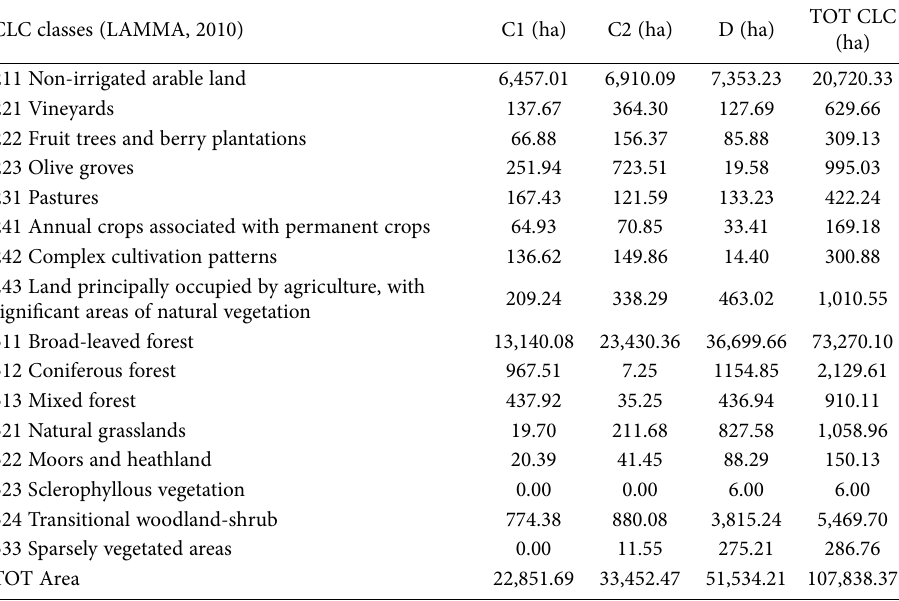
Table A. 1 Distribution of Corine land cover (CLC) classes in Mugello RDP zones. C1: Intermediate rural areas in transition; C2: Declining intermediate rural areas; D: Rural areas with development